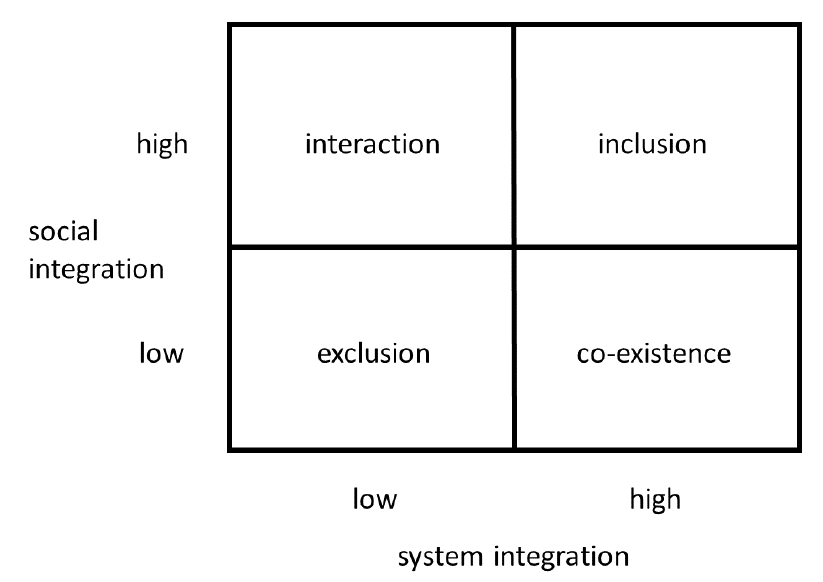
Figure 1 . Social inclusion as realization of system and social